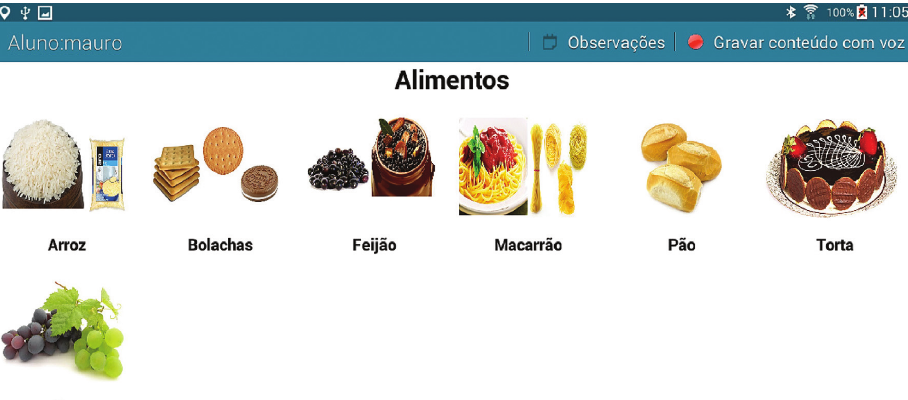
Figure 8: Symbols of the food category.